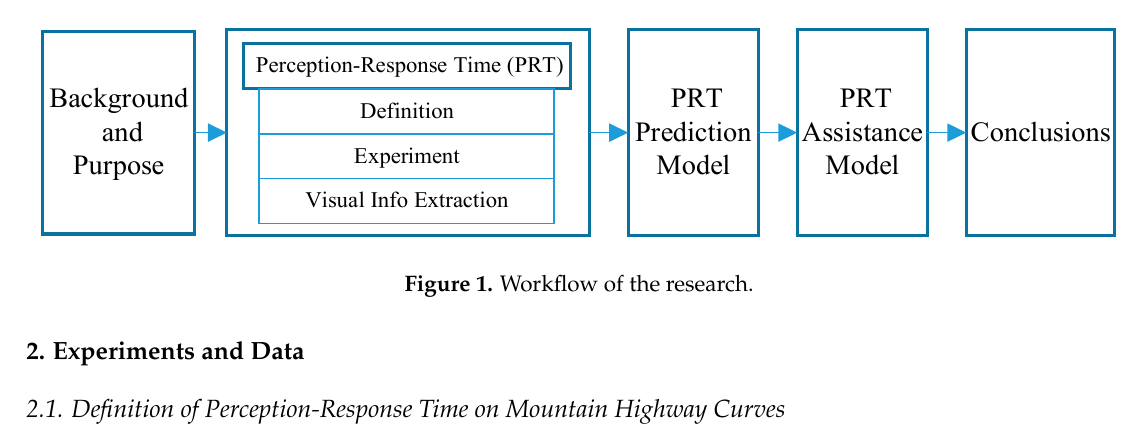
Table 1. Categories of Tested Curves.